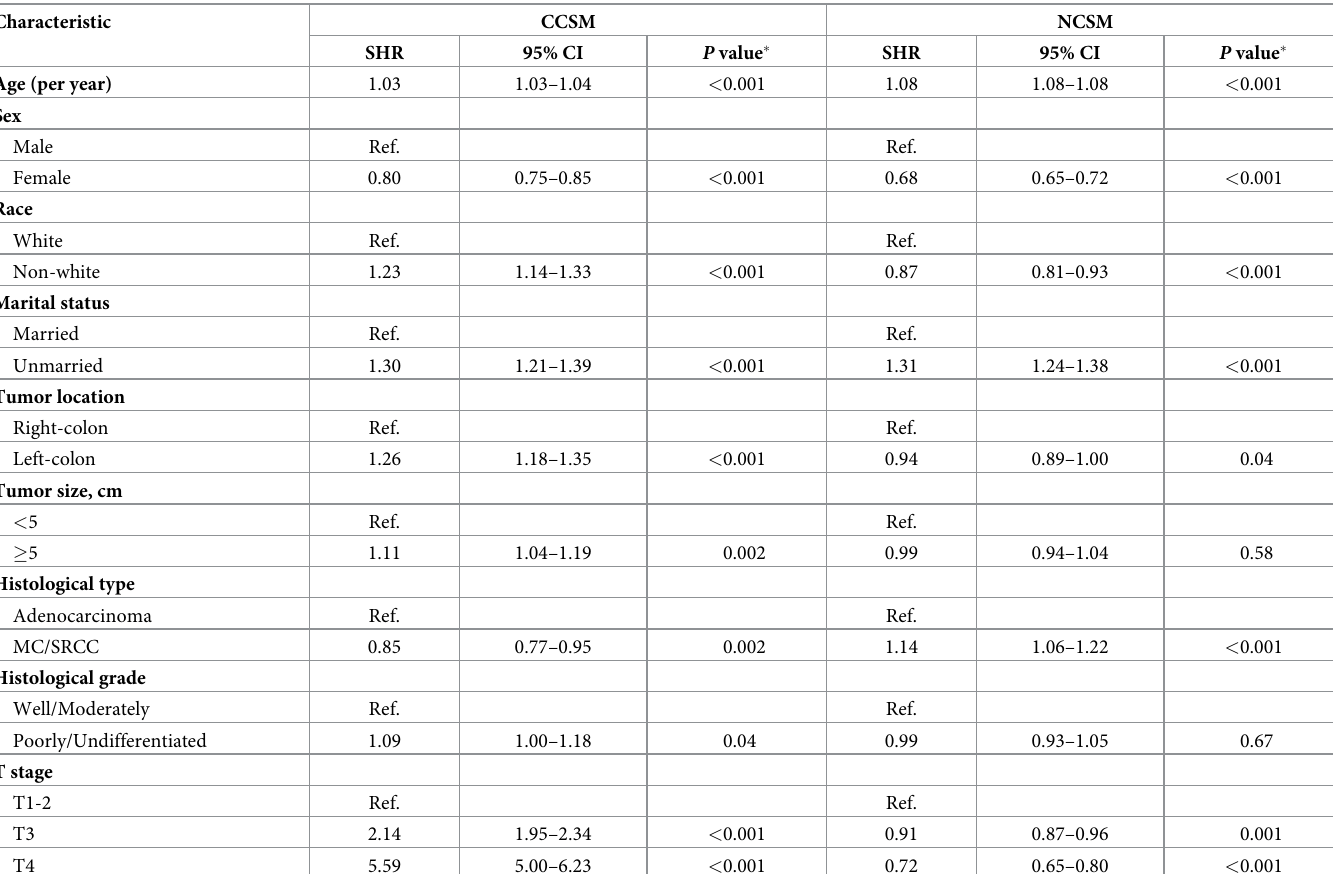
Table 2. Multivariable competing risk analysis for CCSM and NCSM in stage I/II colon